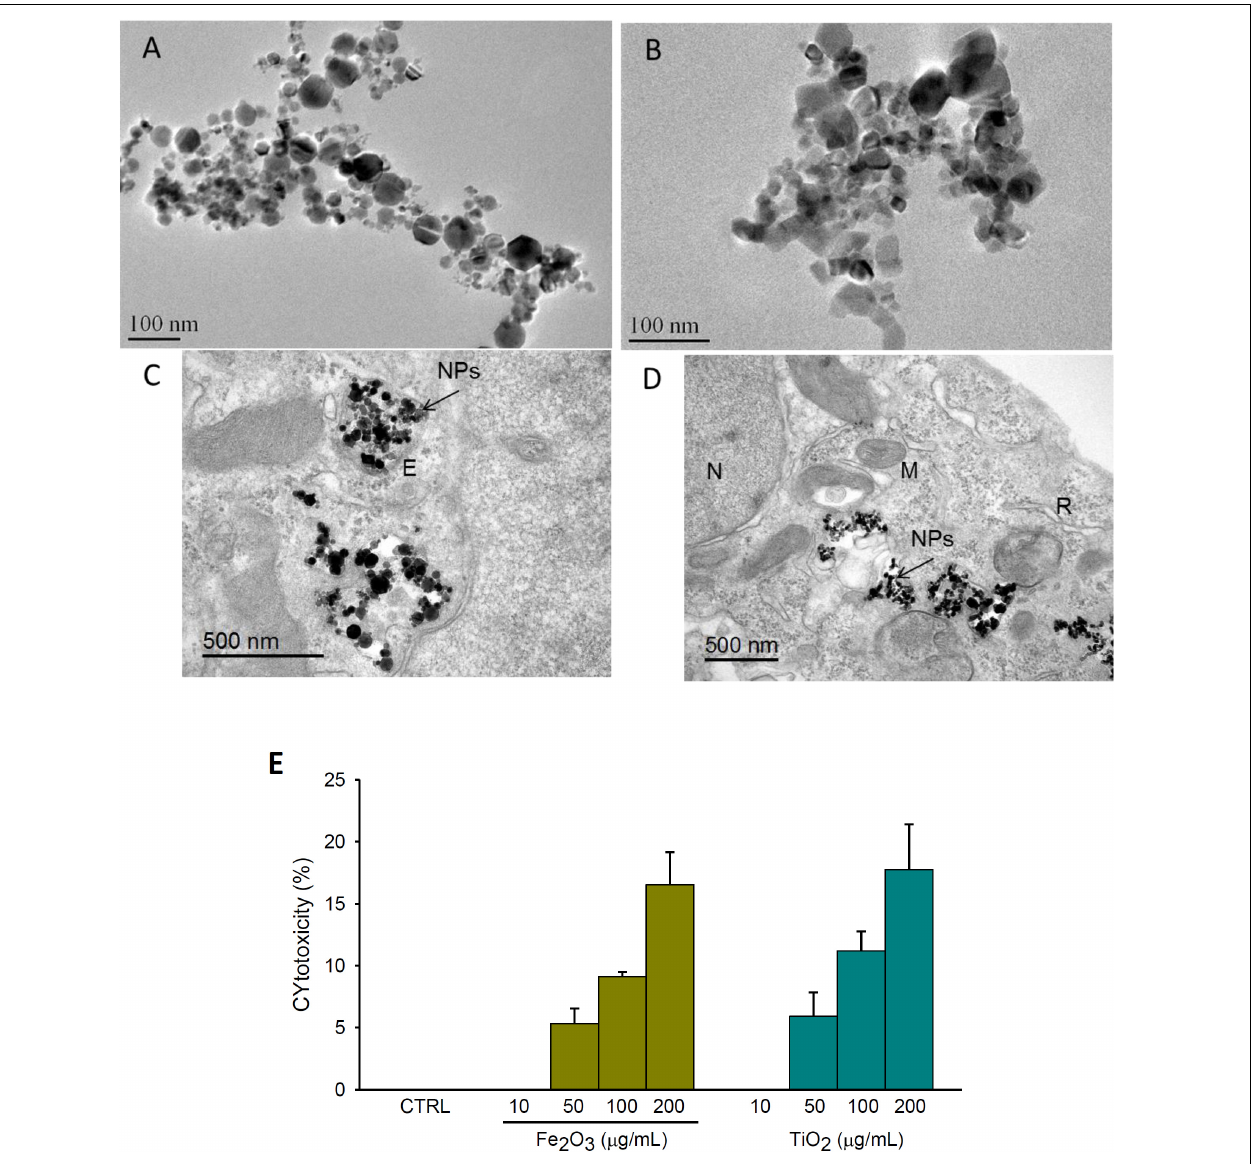
FIGURE 1 | Nanoparticles characterization, internalization and cell viability. Transmission electron microscopy (TEM) images of: (A,B) Fe 2 O 3 and TiO 2 aggregates, respectively; (C,D) A549 cell ultrastructure after 24 h-exposure to 10 µ g/mL of Fe 2 O 3 and TiO 2 NPs, respectively. Note the presence of NPs aggregates trapped in vesicles (C) and also spread in the cytoplasm (D) . Lactate dehydrogenase (LDH) release expressed as percentage of cytotoxicity after 24 h-exposure to 10, 50, 100, and 200 µ g/mL of Fe 2 O 3 and TiO 2 NPs or culture medium (CTRL) in A549 (E) . E, endosome; M, mitochondria; N, nucleus; R, rough endoplasmic reticulum. Data are presented as mean ± SE, n =